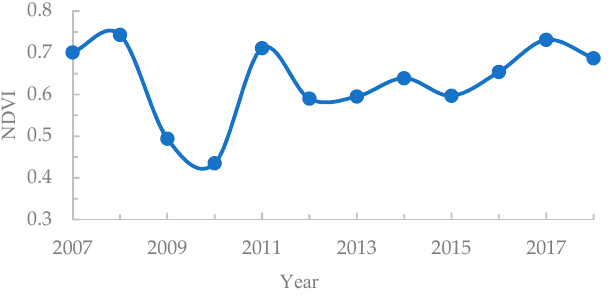
Figure 4. Folding line of MODIS-NDVI annual mean value change from 2007 to 2018 in the Wenchuan epicentral region.